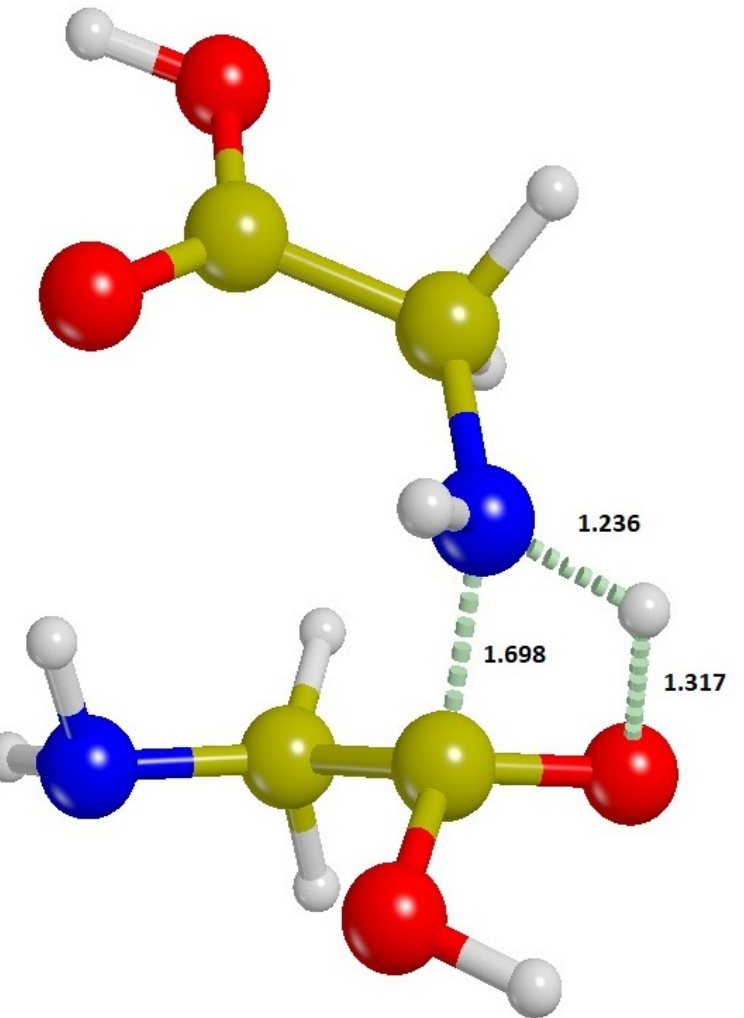
Figure 6. Transition structure for the formation of the peptide bond between two molecules of glycine. The potential energy barrier at the B3LYP/6-31G(d,p) level of theory is 45.95 kcal mol − 1 . Geometries are fully optimized, and distances are in